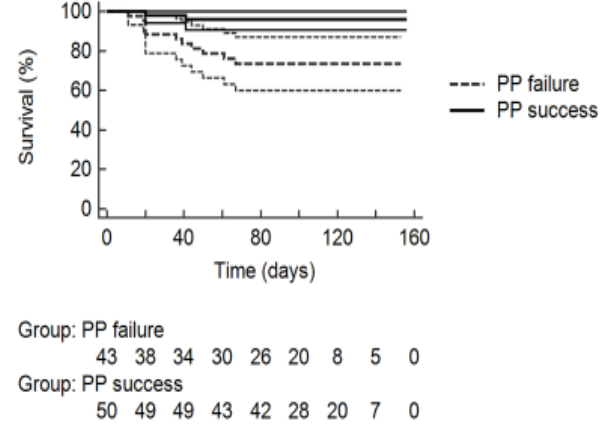
Figure 2. Kaplan–Maier estimates of survival function after Respiratory Intermediate Care Unit admission, stratified according to the group of origin. (PP = Prone Positioning).